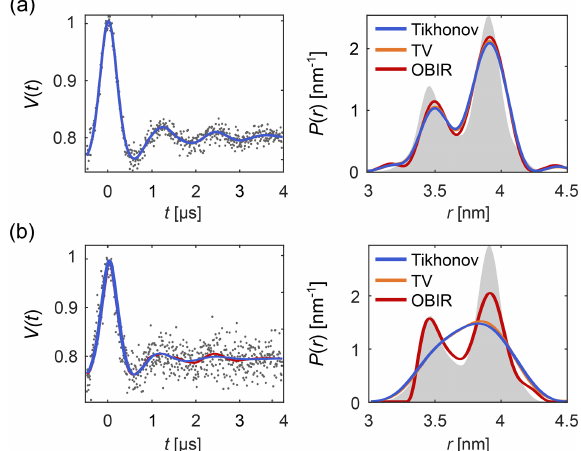
Figure 1. Analysis of background-free dipolar signals with regu- larization. A distance distribution is fit to (a) a low-noise signal and (b) a high-noise signal using Tikhonov regularization (blue), TV regularization (orange), and Osher’s Bregman-iterated (OBIR) regularization (red). In all cases, the AIC was used for the selec- tion of the regularization parameter (see Fig. S1). The input data (simulated) are shown as grey dots and the ground truth distance distribution is shown as grey shaded